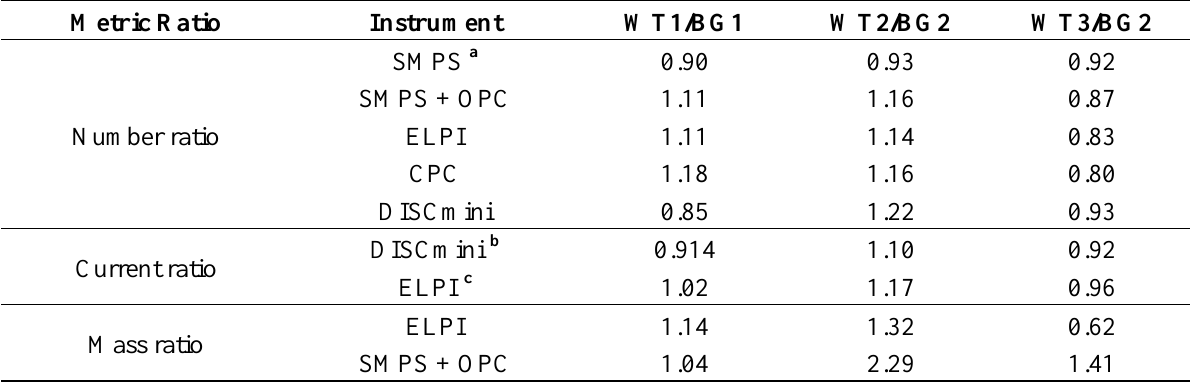
Table A1. Concentration ratios for WT1 , WT2 , and WT3 defined from particle number, current, and mass